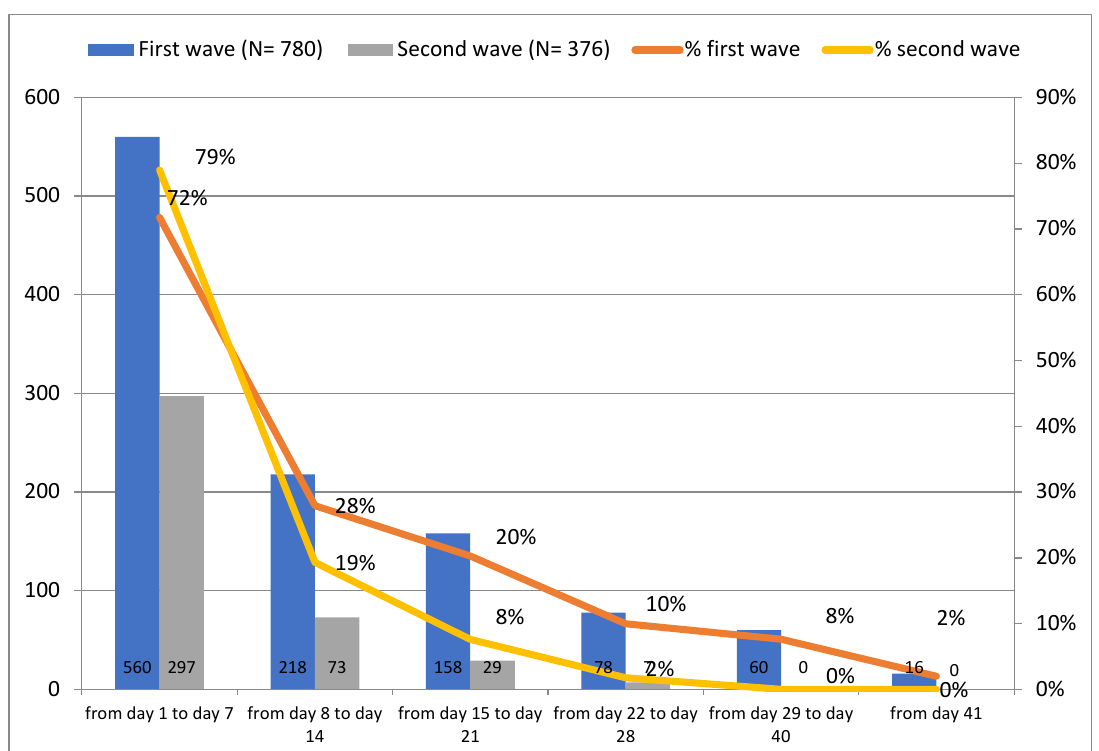
Figure 7. Patients with T > 37 °C per monitoring day.